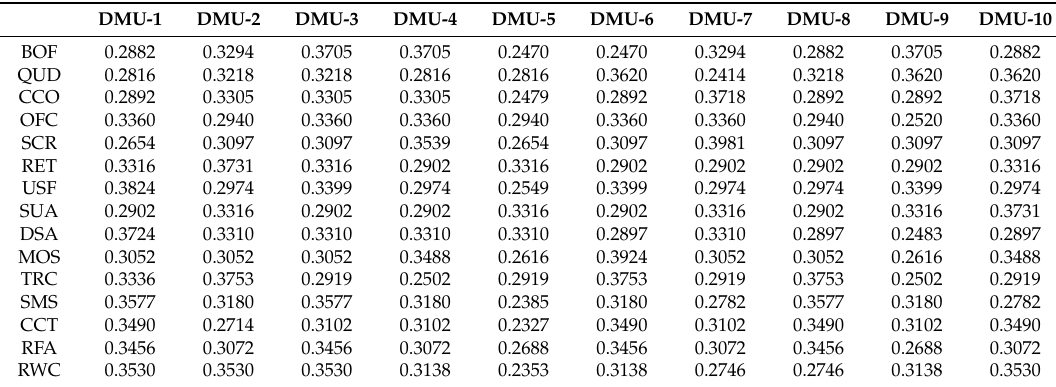
Table 5. The normalized